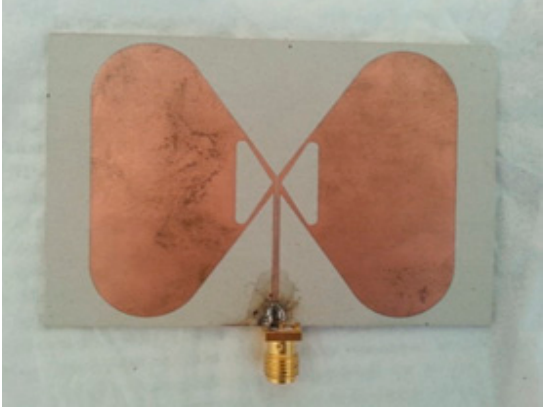
Figure 5. Image of the fabricated wideband bow-tie antenna.